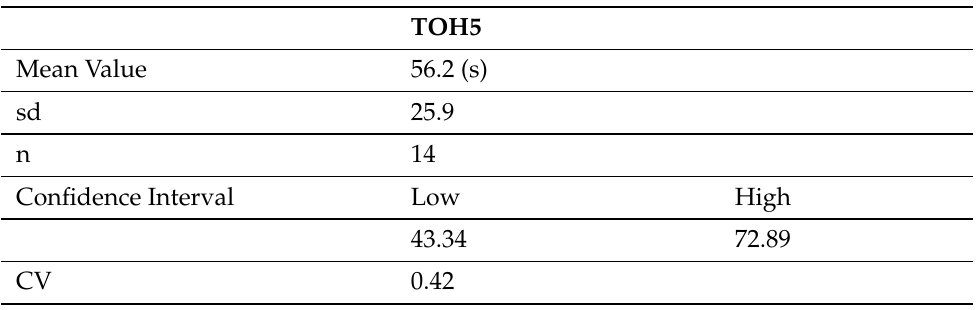
Table 9. Statistics of Time to Task for Task